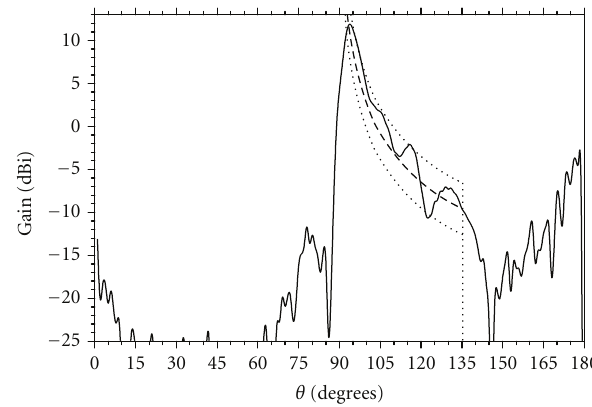
Figure 7: MoM radiation pattern in the elevation plane of the OADC antenna of Case III (solid line), together with the cosecant- squared pattern (dashed line) and its ± 3dB limits (dotted lines).